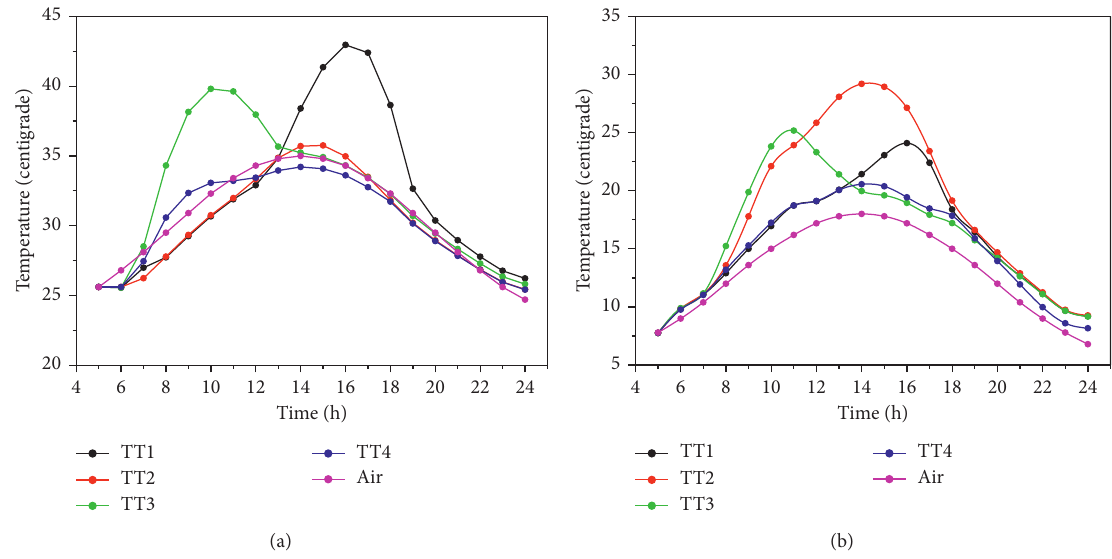
Figure 10: The temperature variation of cross sections of pylons. (a) The temperature variation of cross sections of pylons in summer. (b) The temperature variation of cross sections of pylons in